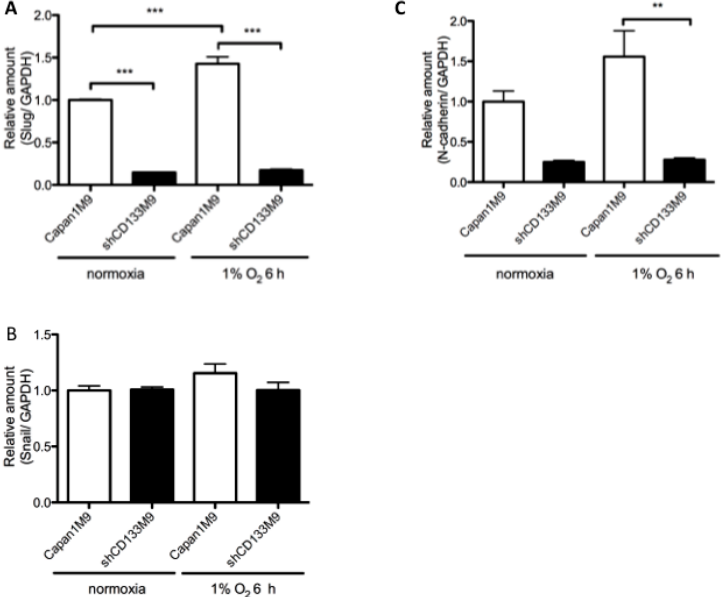
Figure 4. CD133 contributes to EMT phenomenon under hypoxia. ( A ) CD133 silencing down-regulated Slug mRNA level significantly. Hypoxia gained the Slug mRNA level only in Capan1M9; ( B ) Significant difference was not shown in Snail mRNA level; ( C ) CD133 silencing down-regulated N -cadherin mRNA level. Data represent mean ± SD of three experiments; ** p < 0.01; *** p < 0.001.